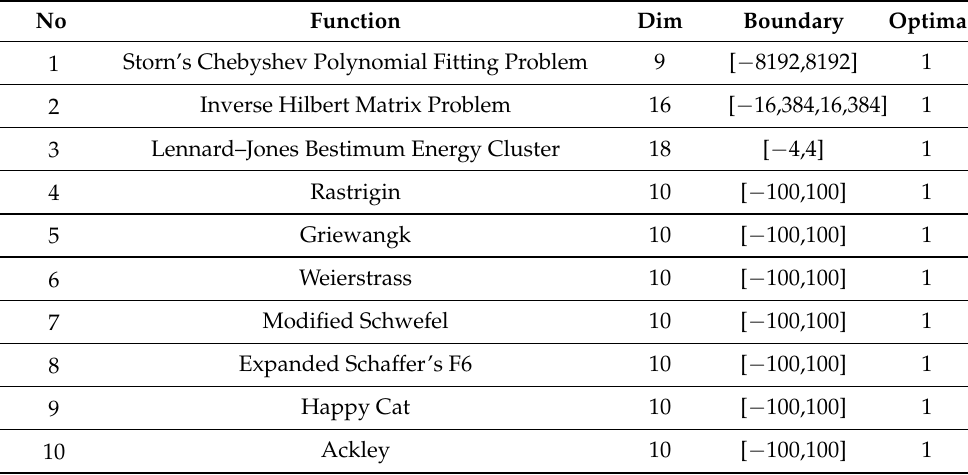
Table 2. Summary of the CEC-2019 function test